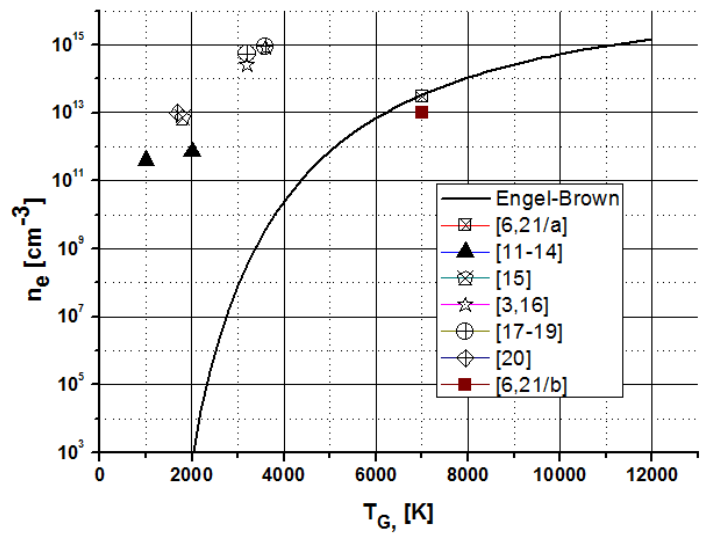
Figure 3. Published n and T data pairs for ELCAD and its homolog discharge plasmas. e G Solid curve represents the equilibrium parameters calculated for H Engel-S.C.Brown approximation (7). [6,21/a] and [6,21/b] points are due to the data of Equations (8/a) and